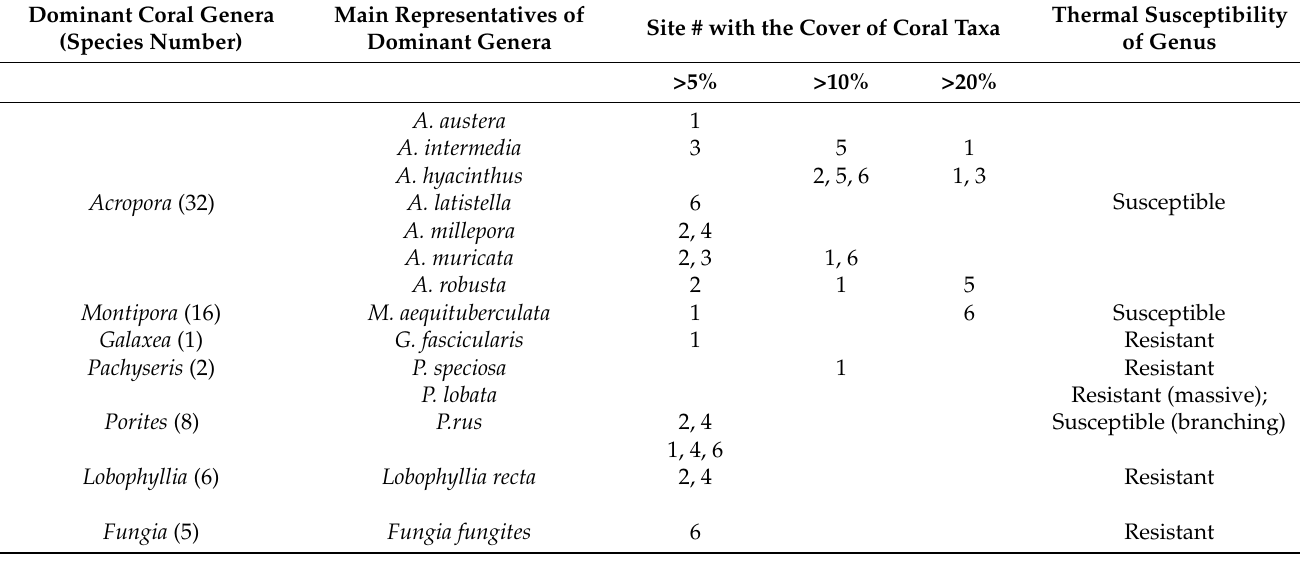
Table 1. Subdivision of recorded stony coral taxa according to their thermal susceptibility. The occurrence of dominant genera in study sites is shown. Thermal susceptibility of coral genera is based on data from